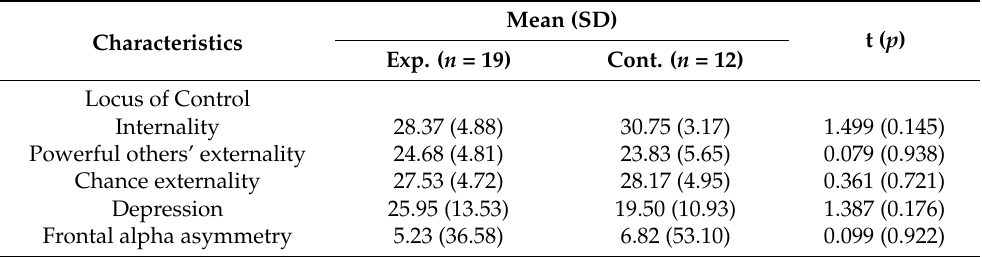
Table 2. Homogeneity of variables.